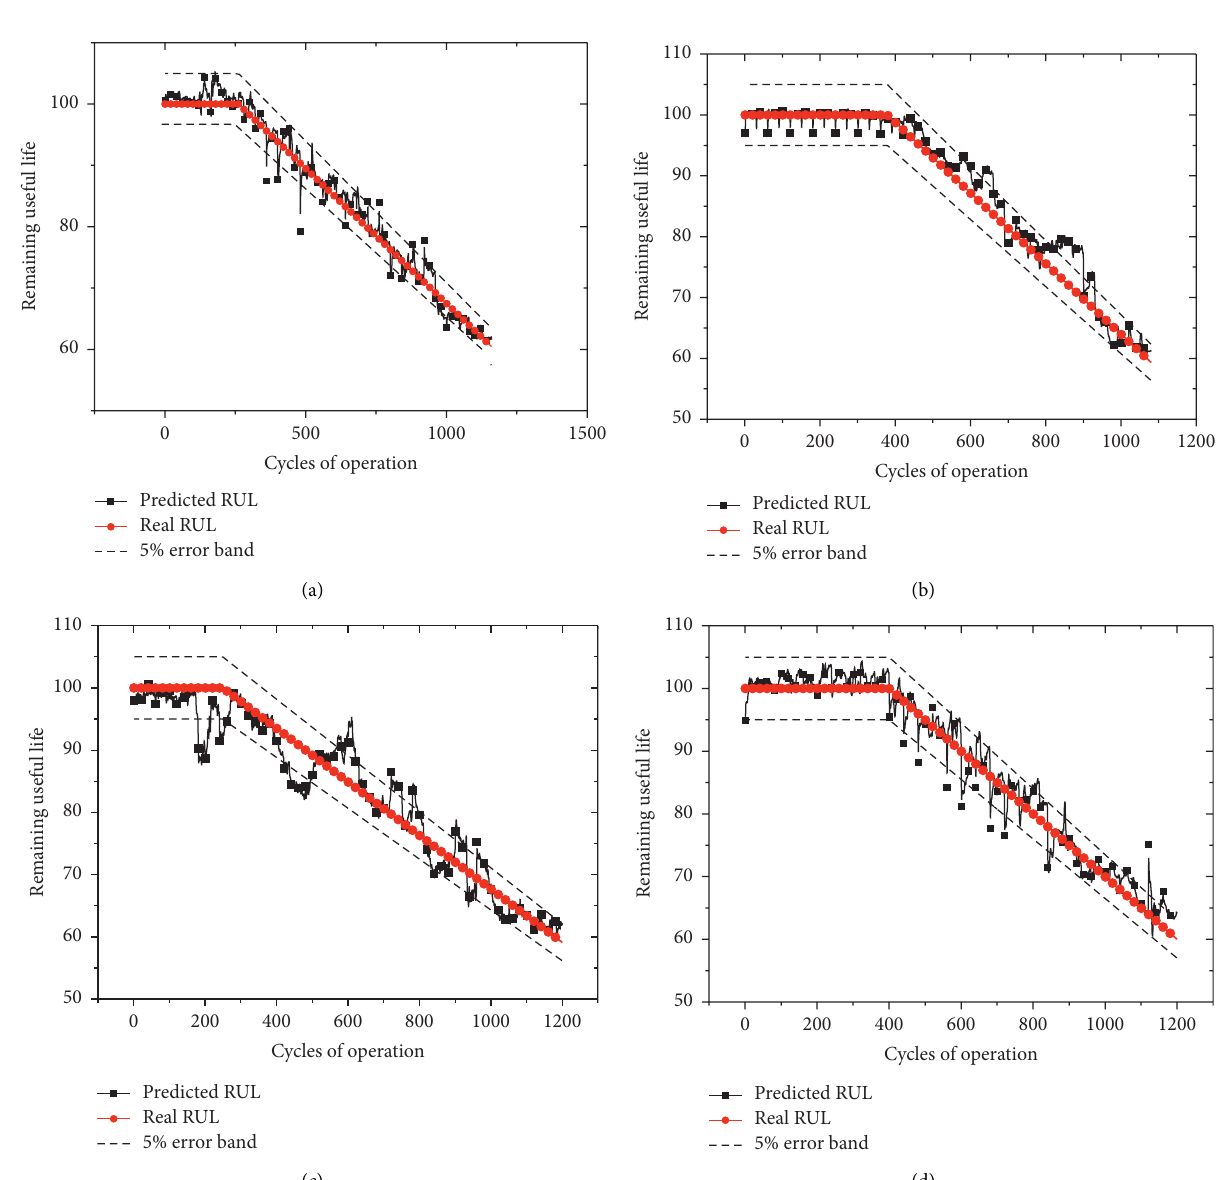
Figure 12: Results of RUL prediction under different conditions. (a) Condition 3 (PF � 30Hz; OP � 30%). (b) Condition 11 (PF � 33Hz; OP � 28%). (c) Condition 23 (PF � 35 Hz; OP � 30%). (d) Condition 34 (PF � 40Hz; OP � 28%). PF means pump frequency, and OP means opening percentage of electric